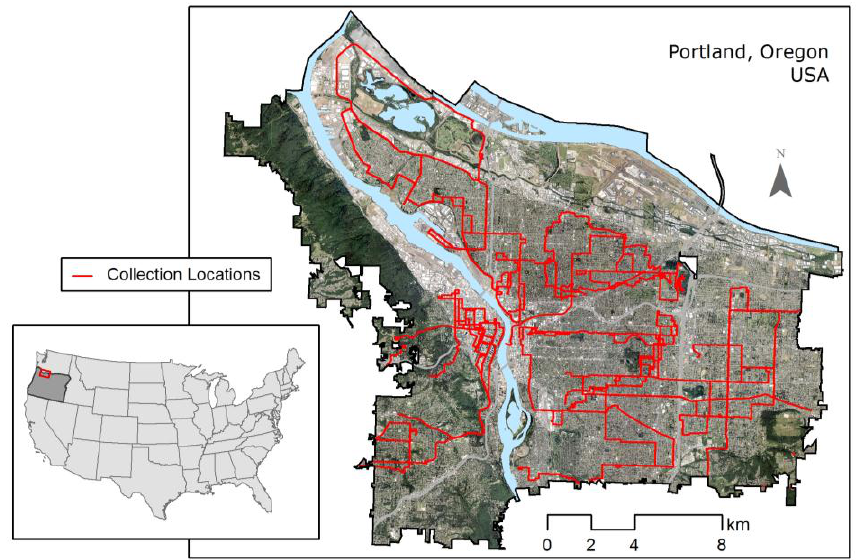
Figure 1. Imagery of Portland, Oregon with coloring (light blue) to accent major rivers. Data collection locations are indicated in red.